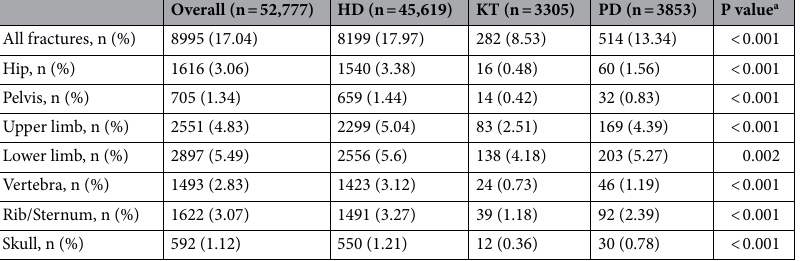
Table 2. Frequency of radiological fractures in kidney replacement therapy populations during follow-up. a P value was based on Chi-square test. HD hemodialysis, KT kidney transplant, PD peritoneal dialysis.